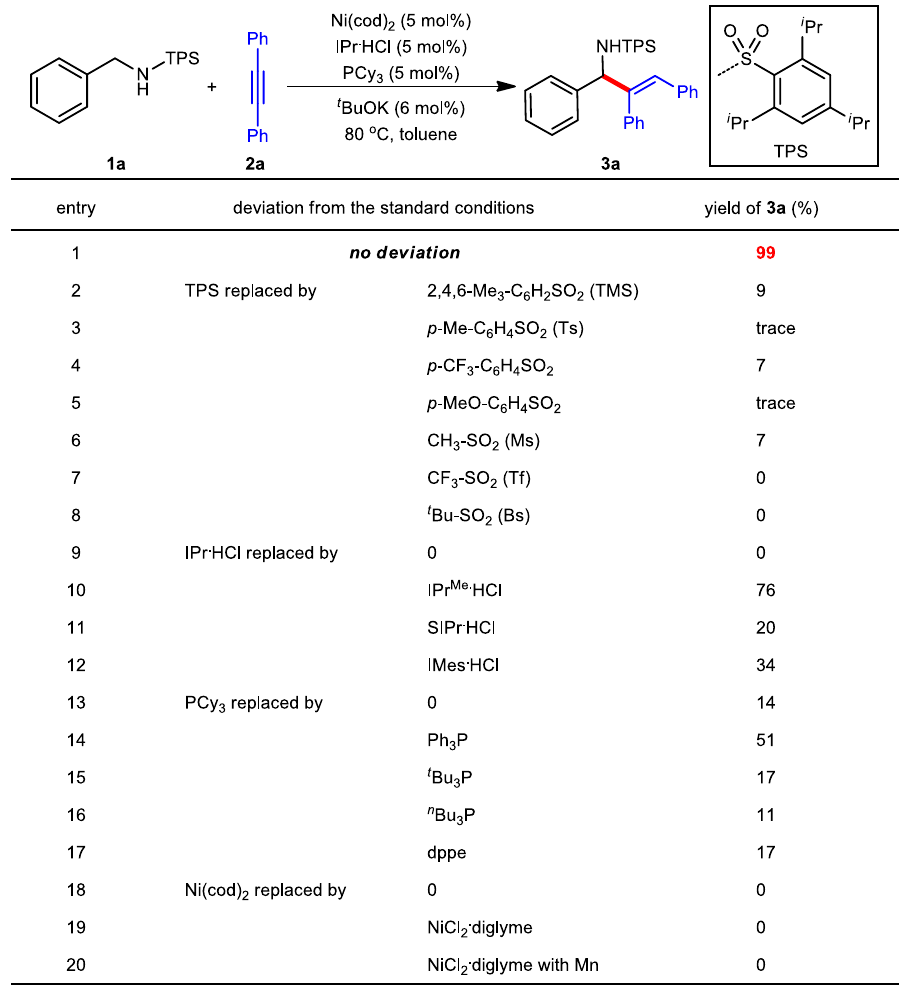
Fig. 2 Reaction optimization. Reaction conditions: 1a (0.20 mmol), 2a (0.22 mmol), toluene (2.0 mL) under N 2 for 1 h; yield was determined by 1 H NMR using Cl 2 CHCHCl 2 as the internal standard. IPr Me = 1,3-bis(2,6-diisopropylphenyl)-4,5-dimethyl-2,3-dihydro-1 H -imidazole. SIPr = 1,3-bis(2,6- diisopropylphenyl)imidazolidine. IMes = 1,3-dimesityl-2,3-dihydro-1 H -imidazole. dppe =